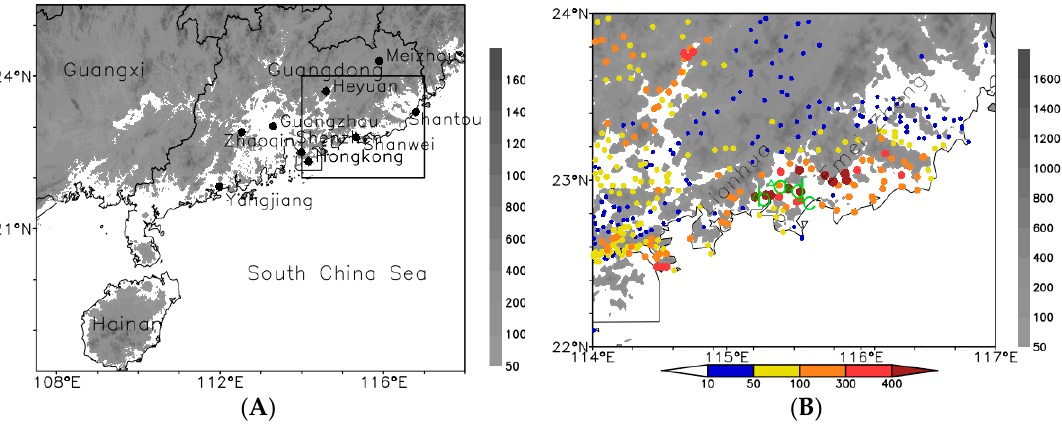
Figure 1. ( A ) Topography (shading) over South China, the rectangle represents the zoomed area in figure b; the dots represent the radar stations. ( B ) The 24-h accumulated rainfall at 1200 UTC on 20 May 2015. The character a, b, c and d next to the green triangle represent Haifeng, G1803, G1827 and G1847 in Figure 2.